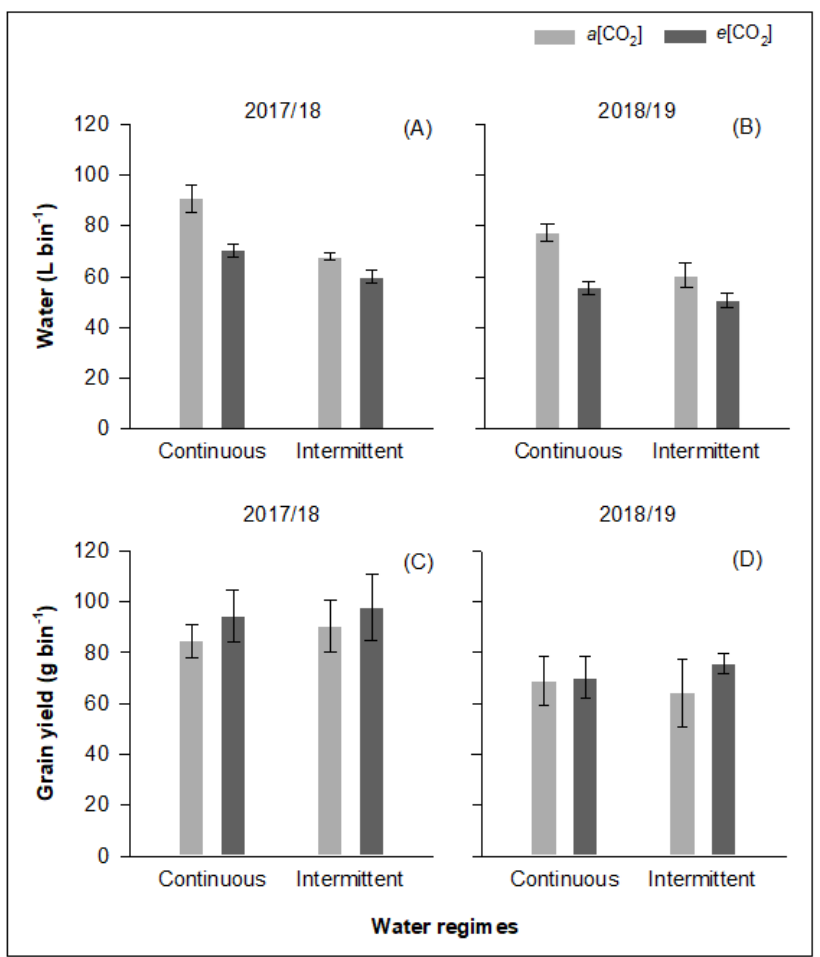
Figure 5. Effect of CO 2 concentrations ( a [CO 2 ] = 400 μmol mol −1 and e [CO 2 ] = 700 μmol mol −1 ) and water regimes (continuous vs. intermittent flood) on the water used for irrigation ( A , B ) and grain yield ( C , D ) of rice plants. Error bars correspond to 95% confidence intervals.